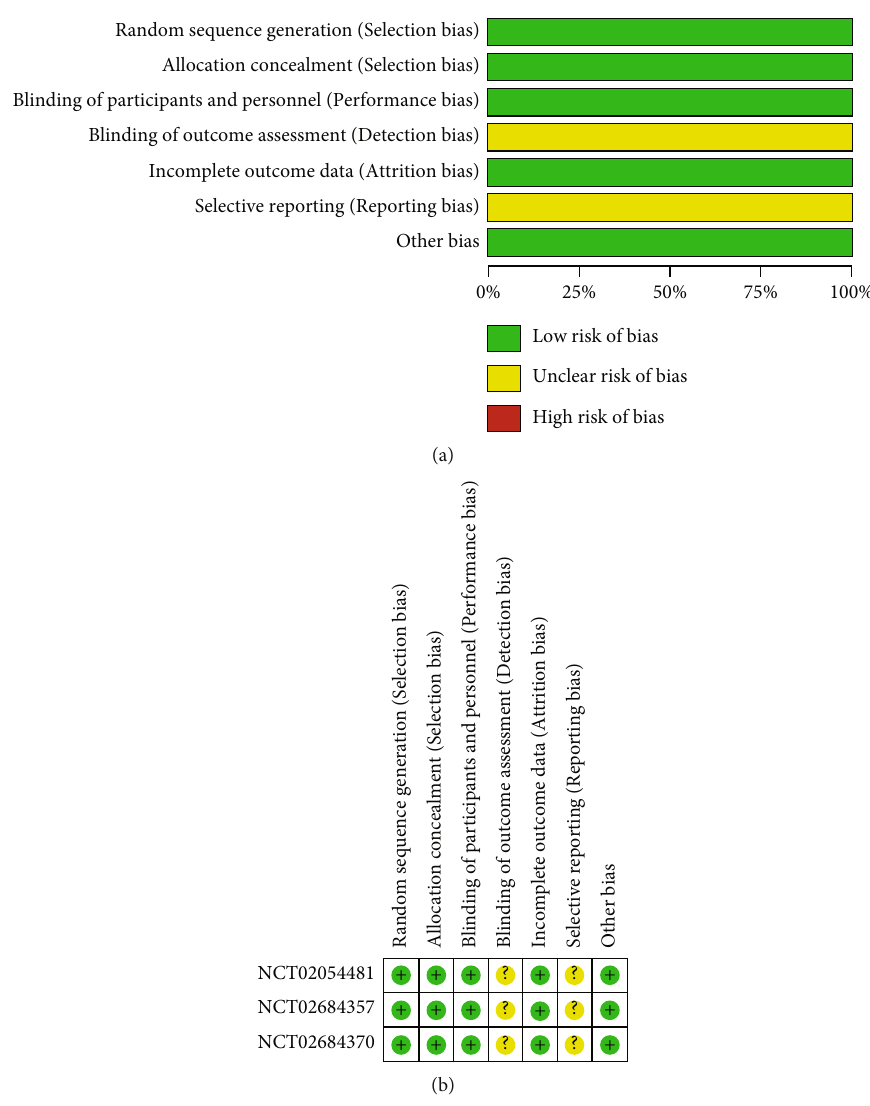
Figure 2: (a, b) Risk of bias of included